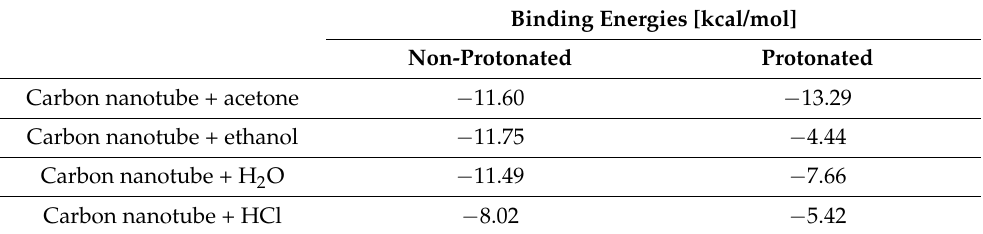
Table 1. Binding energies [kcal/mol] between carbon nanotubes and solvent molecules.